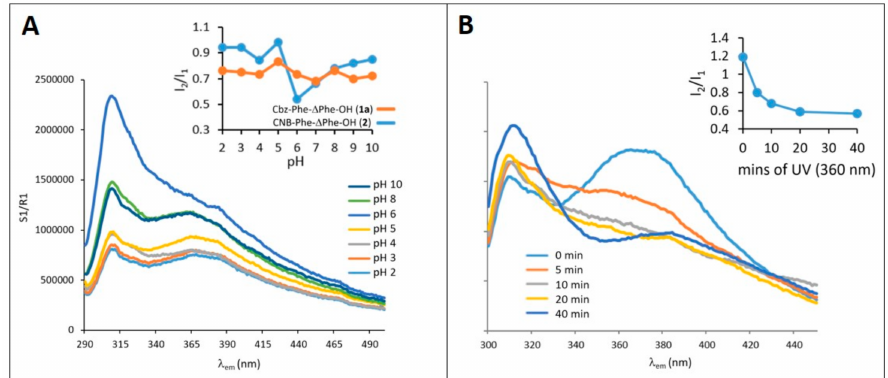
Figure 6. Panel ( A ): Dependence of fluorescence emission on pH of hydrogelator 2 (10 µ M, λ exc = 280 nm). Panel ( A ) inset: pH dependence of aggregate (I 2 , measured at 370 nm) to monomer (I 1 , measured 315 nm) emission band intensity ratio of hydrogelator 2 and comparison with 1a . Panel ( B ): Change of fluorescence emission of hydrogelator 2 following UV irradiation for 0 min, 5 min, 10 min, 20 min, and 40 min (measured at pH 5). Right: Fluorescence emission spectrum of hydrogelator 2 at pH 5 versus time irradiated with 360 nm UV light (mins). Panel ( B ) inset: Aggregate (I 2 , measured at 370 nm) to monomer (I 1 , measured 315 nm) emission band intensity ratio of hydrogelator 2 versus time irradiated with 360 nm UV light